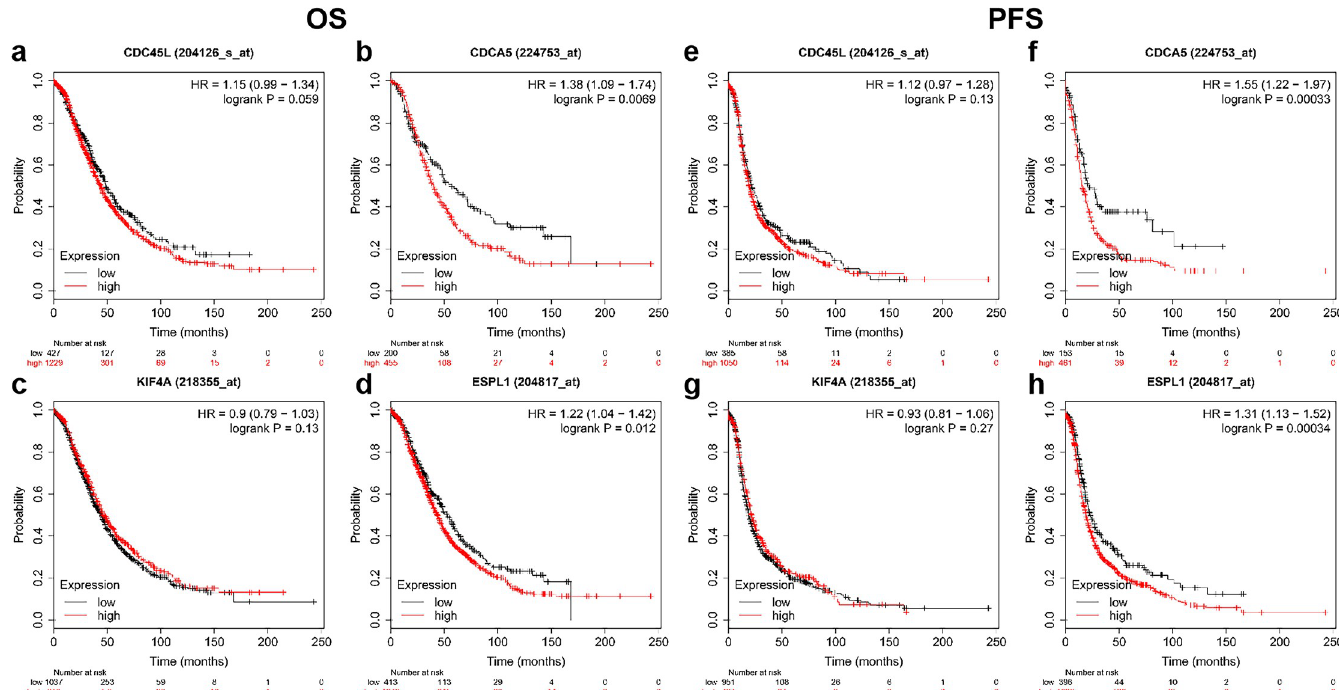
Fig 7. Overall survival and progression-free survival curves of DEGs in patients with EOCs from TCGA database. The relatively higher expression of CDC45 had no statistical influence on patients’ overall survival. (b) The relatively higher expression of CDCA5 was associated with poor prognosis of EOC patients. (c) The relatively higher expression of KIF4A had no statistical influence on patients’ overall survival. (d) The relatively higher expression of ESPL1 was associated with poor prognosis of EOC patients. (e) The relatively higher expression of CDC45 had no statistical influence on patients’ progression-free survival. (f) The relatively higher expression of CDCA5 was associated with poor prognosis of EOC patients. (g) The relatively higher expression of KIF4A had no statistical influence on patients’ progression-free survival. (h) The relatively higher expression of ESPL1 was associated with poor prognosis of EOC patients.